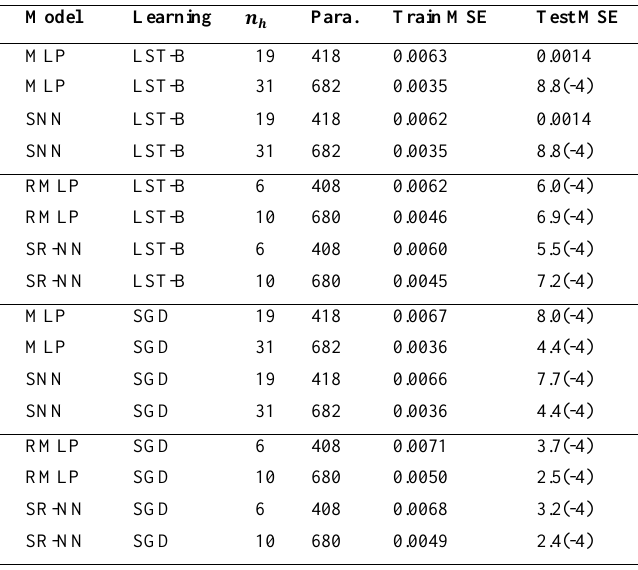
Table 2. Normalized MSE of MLP, SNN, RMLP, and SR-NN in the identification of CRK. 𝒏 𝒉 denotes the number of hidden (rough)